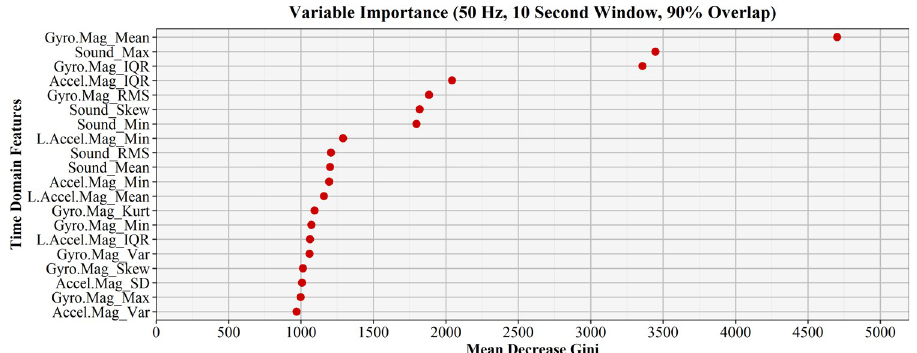
Fig 11. Time domain feature variable importance. Variable importance of the top 20 time domain features used during model development for the best performing activity recognition algorithm in terms of mean decrease in Gini.